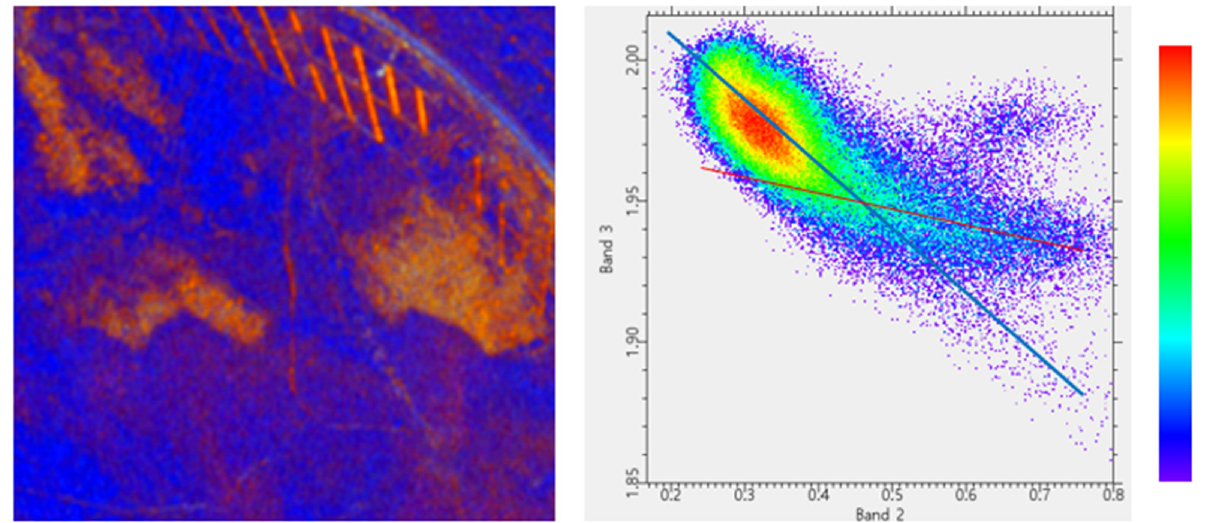
Figure 10. The scattergram of HH TS tr-SVD 2/3 bands ( left ) over the hidden features ( right ) shown in Figure 8b(I).